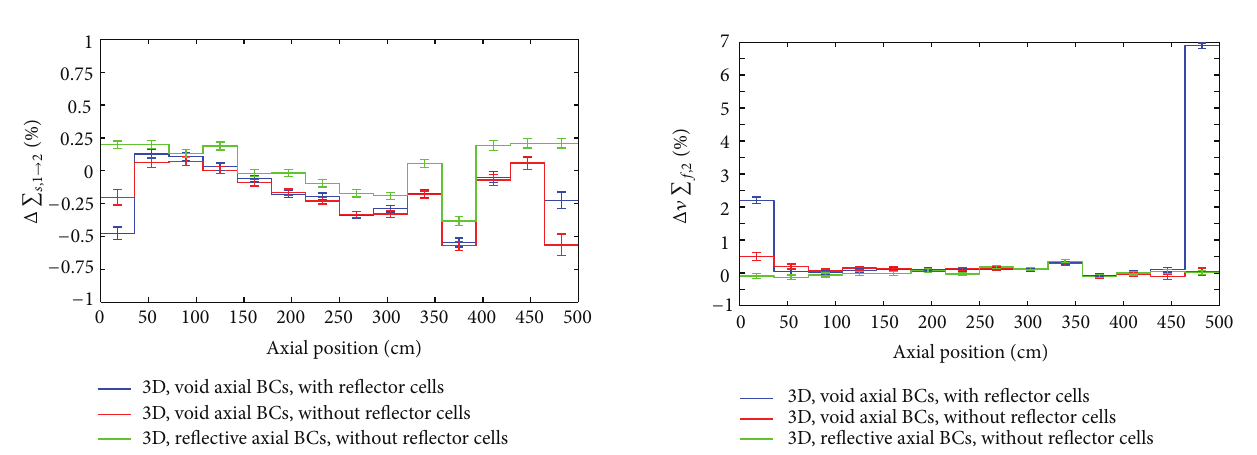
Figure 13: Relative differences between down scattering cross sections.